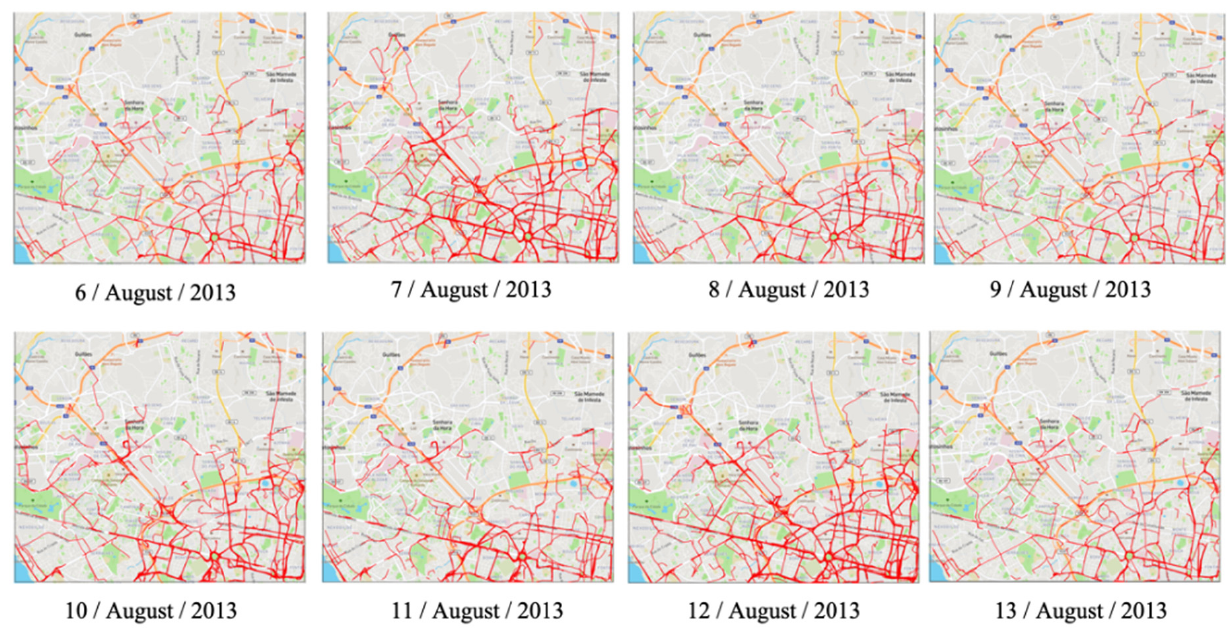
Figure 20. Slow segment evolution of a cell from 6 August 2013 to 13 August 2013 and from 8:00–10:00, 60